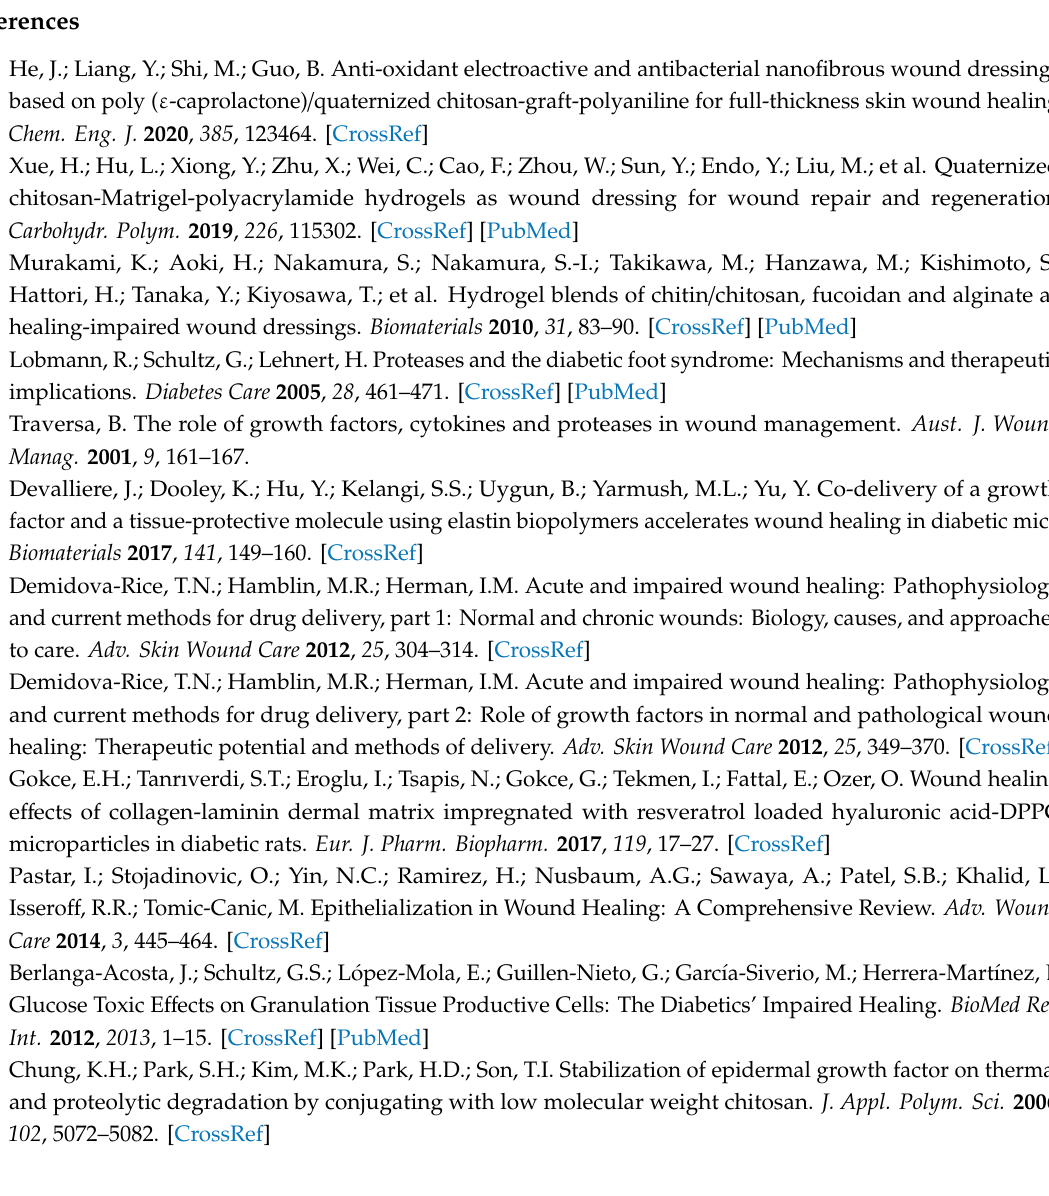
Figure S1: Histological images of wound beds with Masson’s trichrome staining, Figure S2: Histological images of wound beds with pancytokeratine staining, Table S1: Body weights of mice used for cytokine